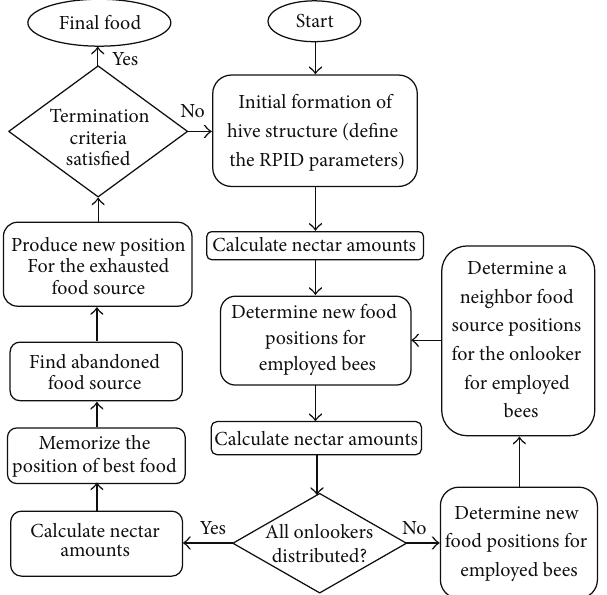
Figure 1: Algorithm and computational flowchart of IABC.